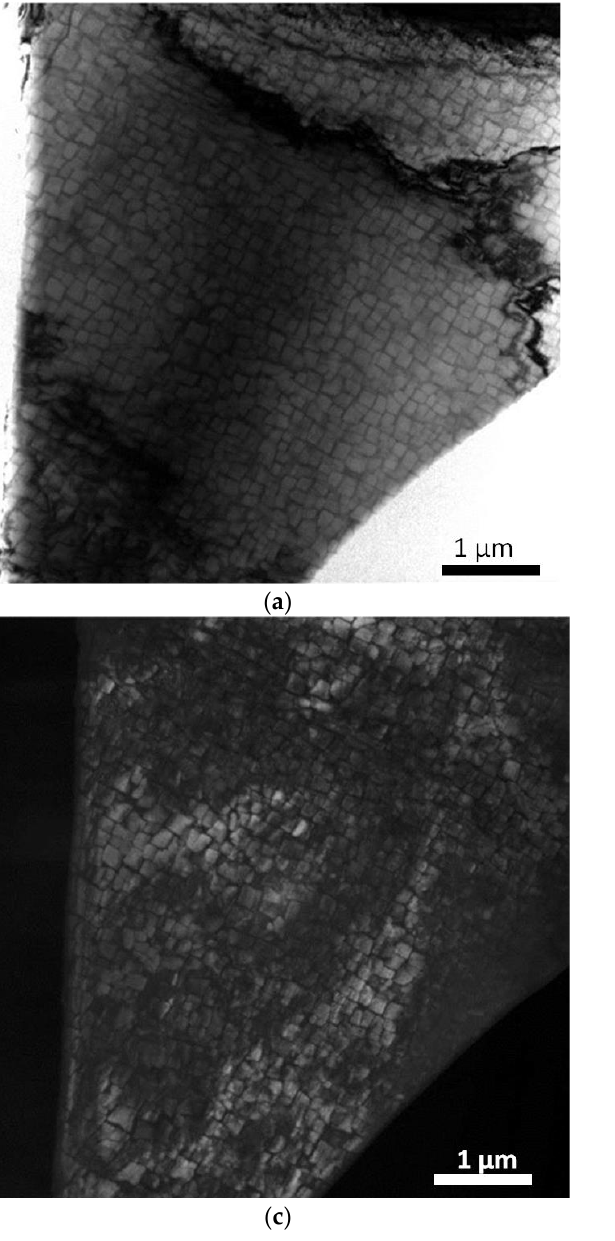
Figure 7. Fine structure of products material obtained by wire-feed electron beam additive manufacturing at a distance from the substrate of 40 mm (in the last layer). Bright-field ( a , b ) and dark-field ( c ) TEM images, SAED and its identification scheme ( d ). Dark-field image taken in the of reflection 100 γ’ .